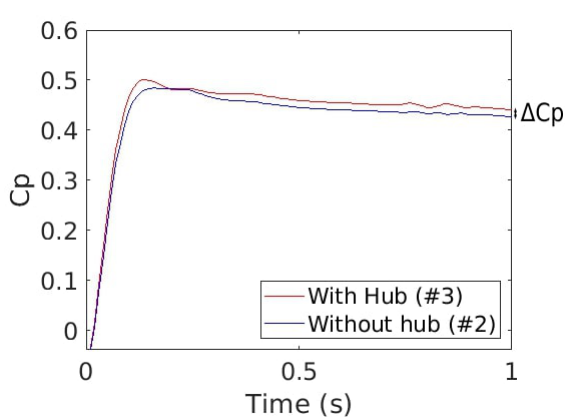
Figure 17. Time evolution of Cp for the cases with (#3 red line) and without a hub (#2.0 blue line).